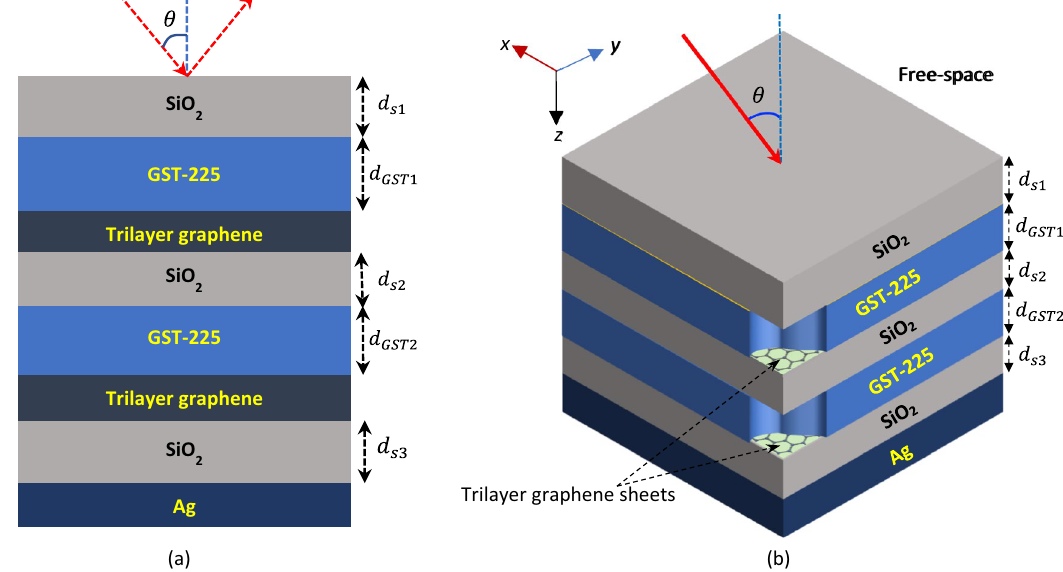
Figure 1. ( a ) 2D and ( b ) 3D schematics of the proposed GST-graphene-SiO 2 mediums-based multilayered planar structure.